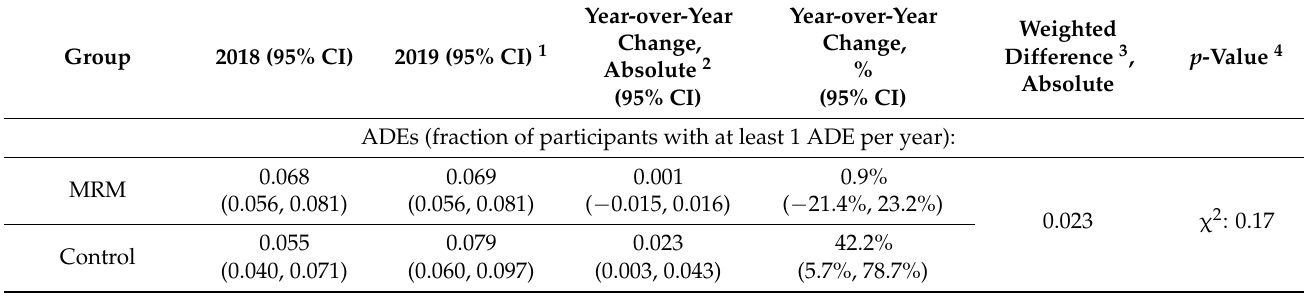
Table 5. Year-over-year changes in clinical outcomes adjusted by hierarchical condition category scores 1 .